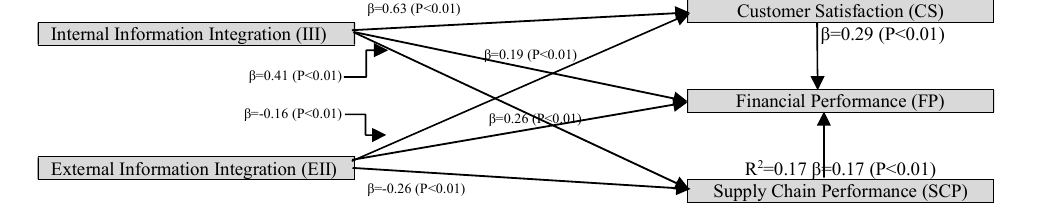
Fig. 2. Result of the structural model